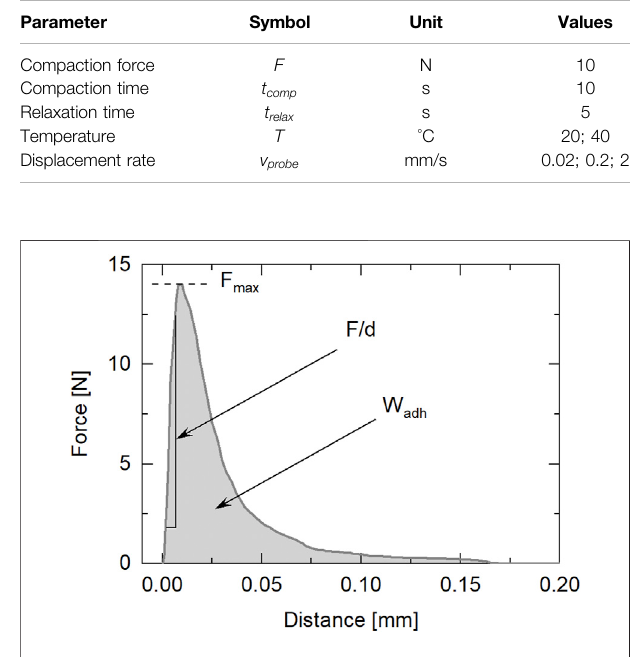
FIGURE 2 | Probe tack test —